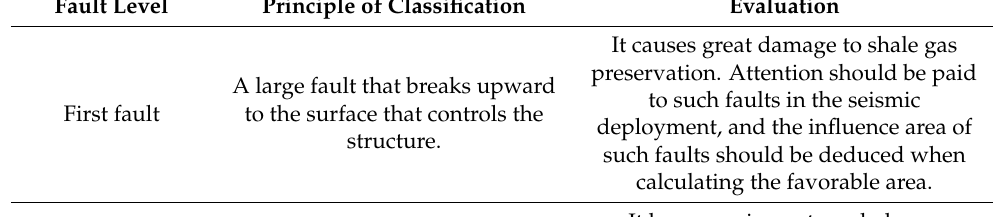
Table 2. Fault classification in the Luzhou